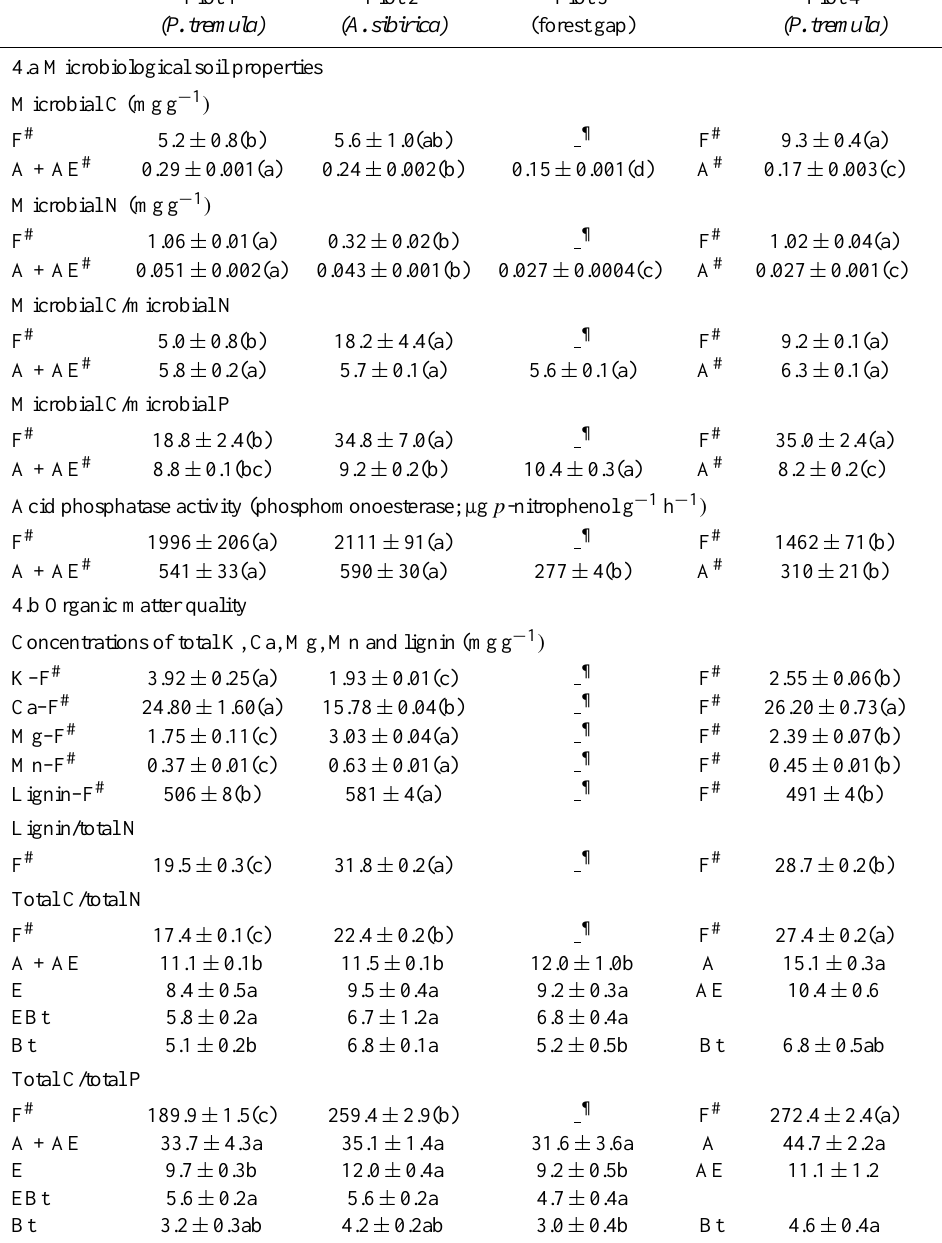
Table 4. Microbiological soil properties and organic matter quality. Plot 1 Plot 2 Plot 3 Plot 4 (P. tremula) (A. sibirica) (forest gap) (P.